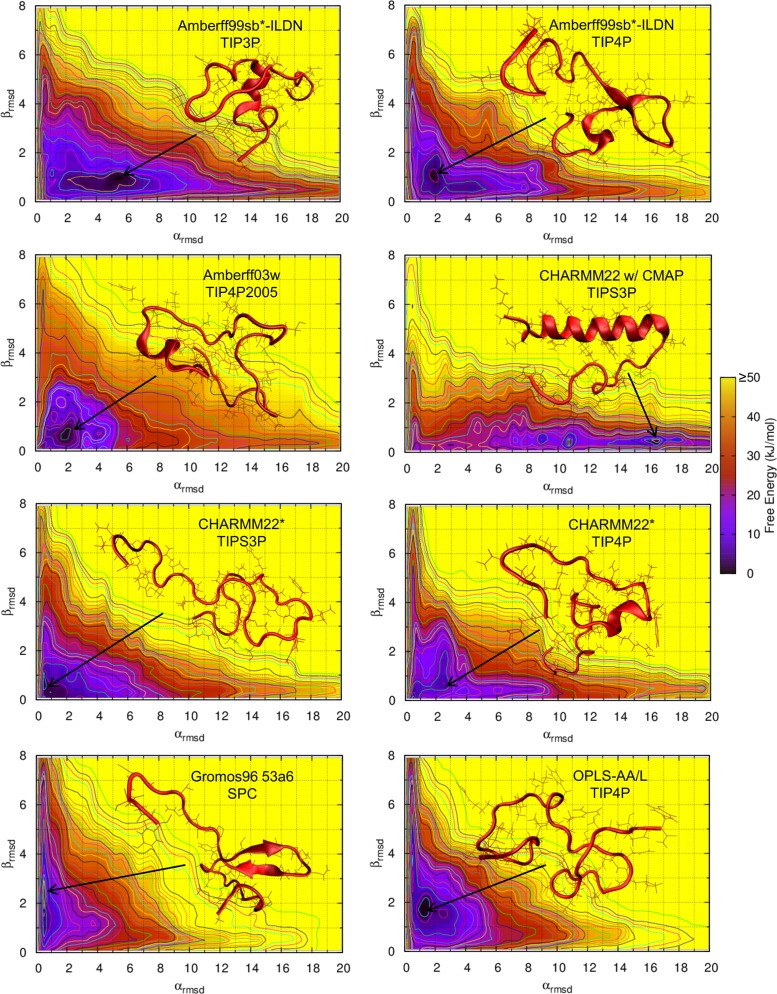
Free energy of rat amylin as a function of αRMSD and βRMSD for various force fields.The darker regions indicate regions of lower free energy.